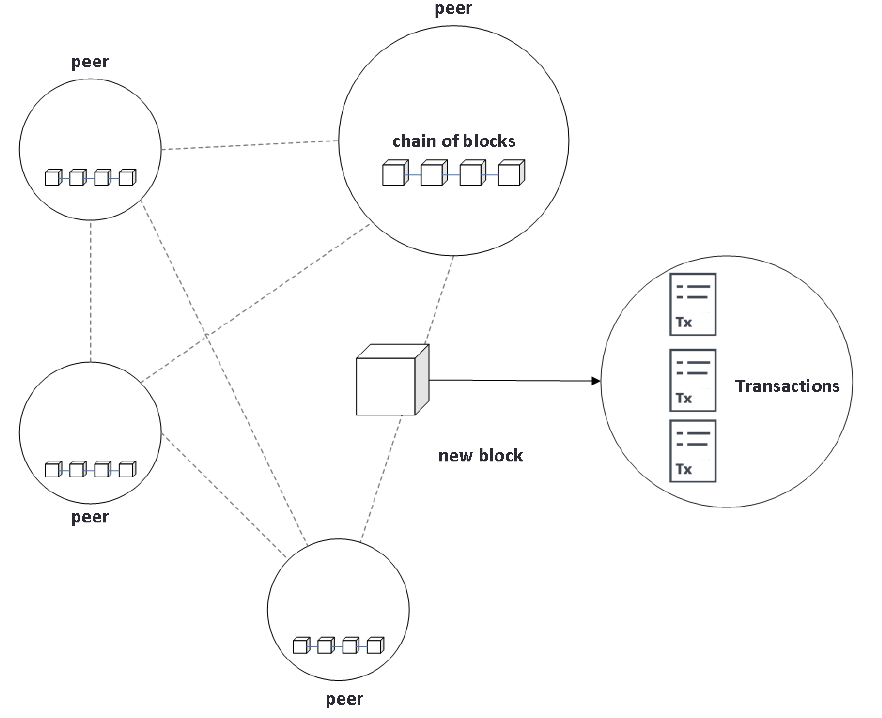
Figure 2. Distributed network between